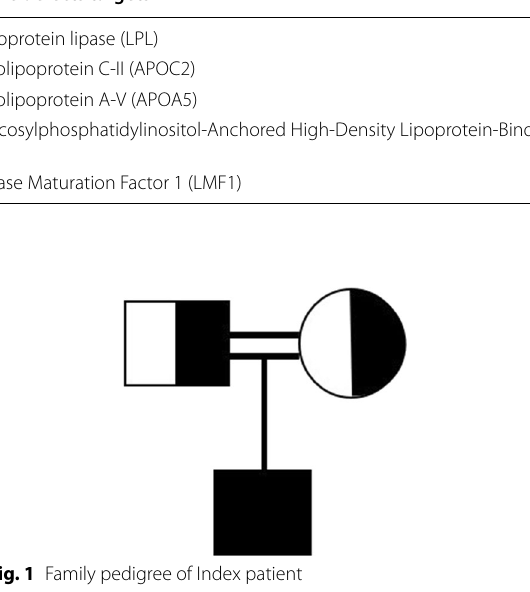
Table 1 Mediators of triglyceride metabolism Gene defects targets